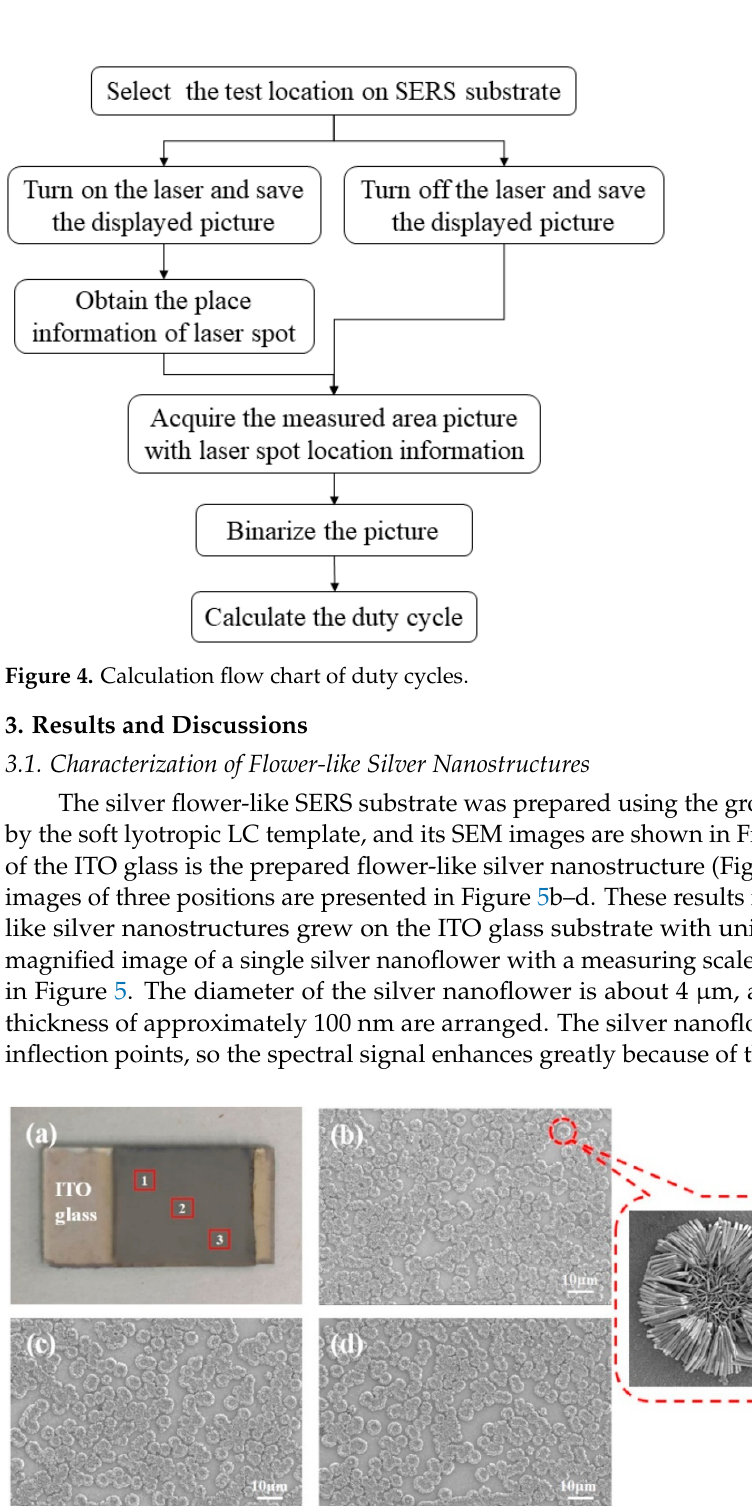
Figure 5. ( a ) Fabricated SERS substrate. ( b – d ) SEM images of the silver flower-like nanostructures in three different positions (scale bar 10 μ m).